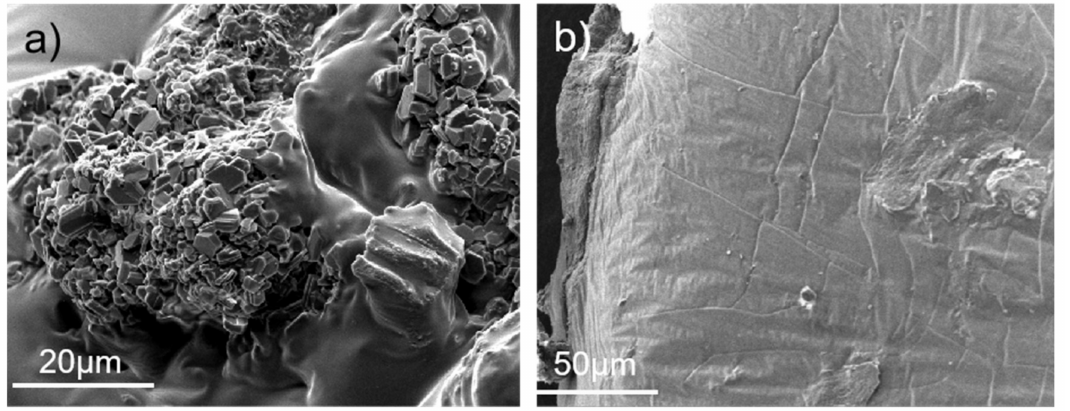
Figure 11. Cross-sectional SEM image of ( a ) SR-Pd/C and ( b )